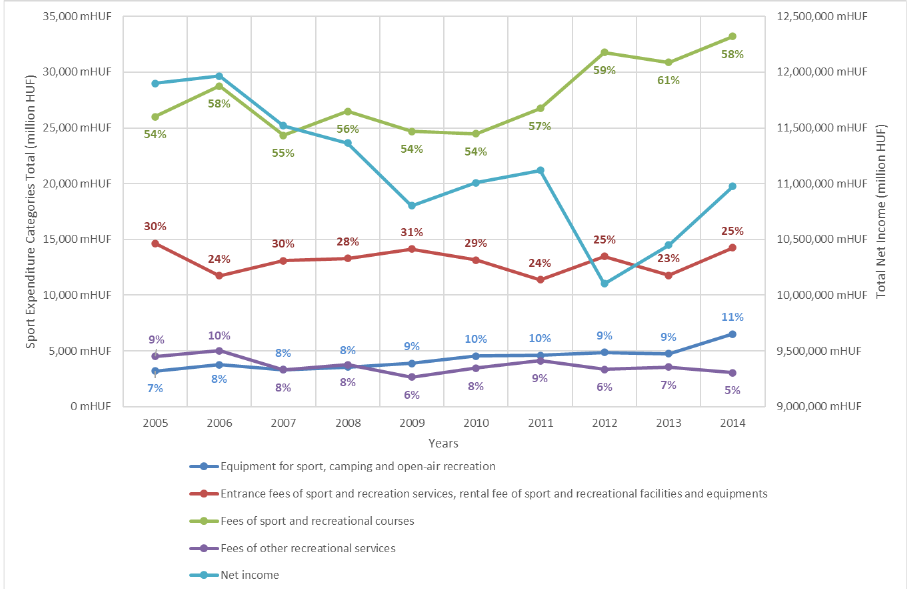
Figure 4. Development of sport expenditure’s aggregate values and incomes between 2005 and 2014, (percentage data shows the proportion of aggregated sport expenditure items). Source: own calcu- lation.